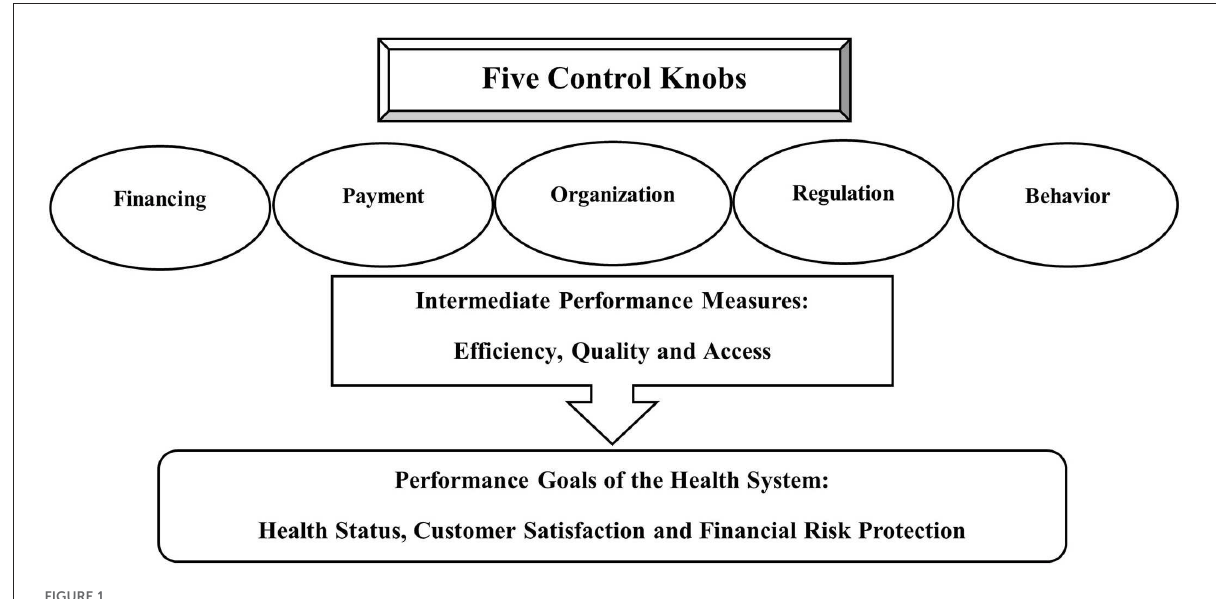
FIGURE1 Visual illustration of the elements of the Flagship